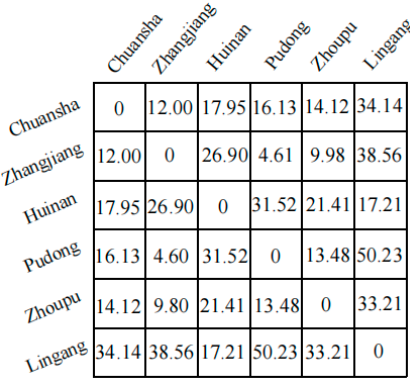
Figure 8. The distance matrix of six counties.